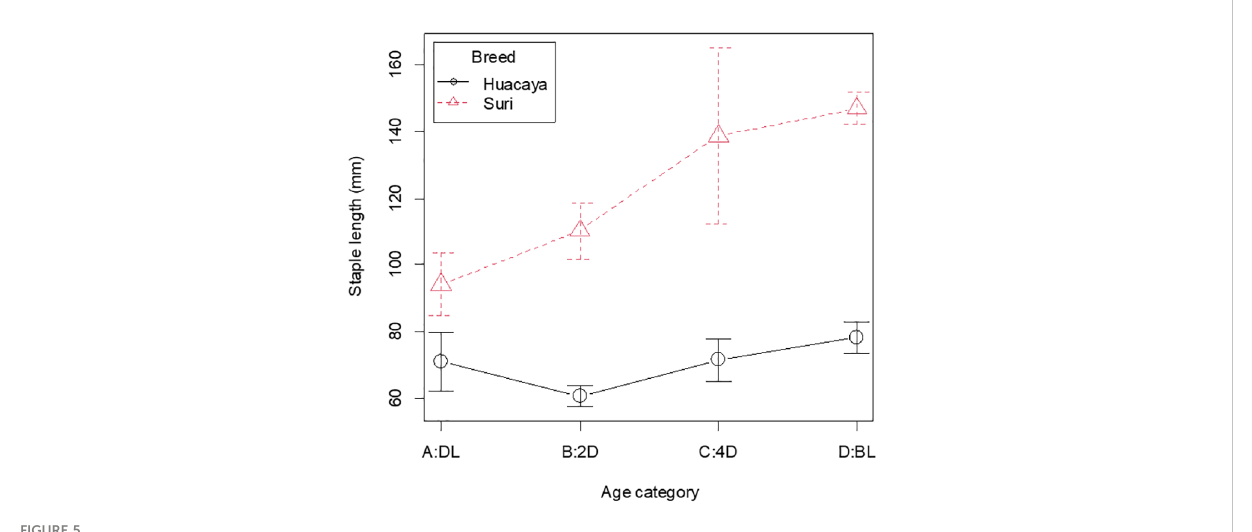
FIGURE 5 Interaction between breed and age on the mean staple length ± standard error.